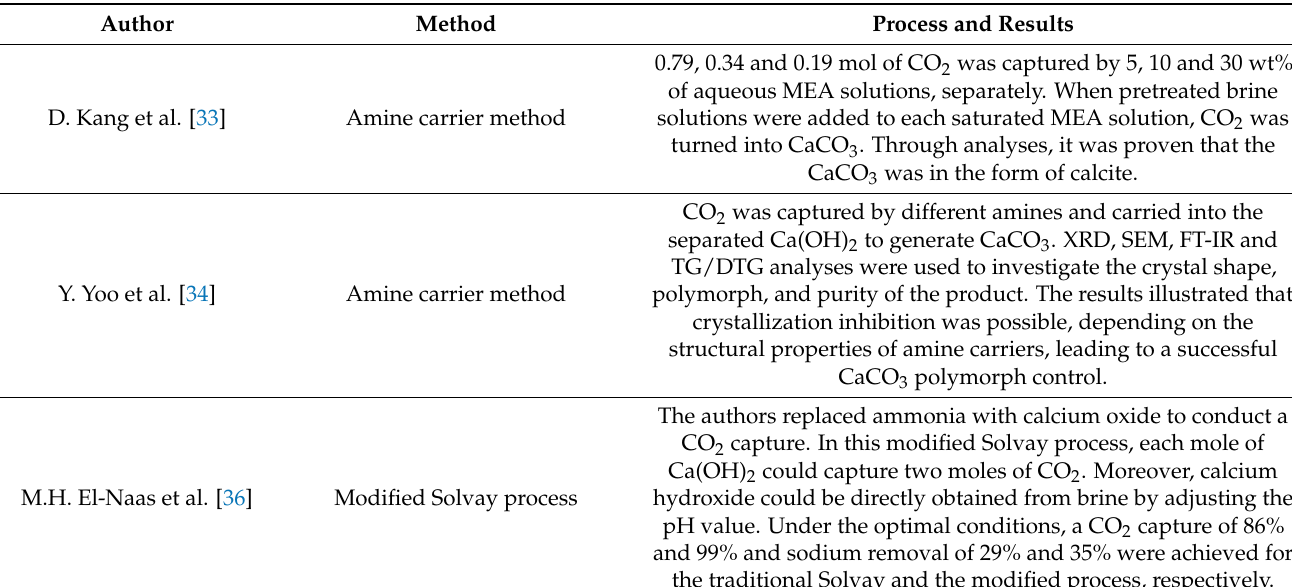
Table 1. The outputs of previous